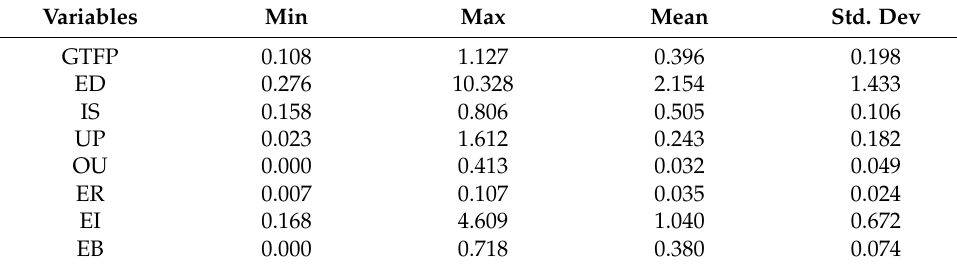
Table 3. Descriptive statistics of